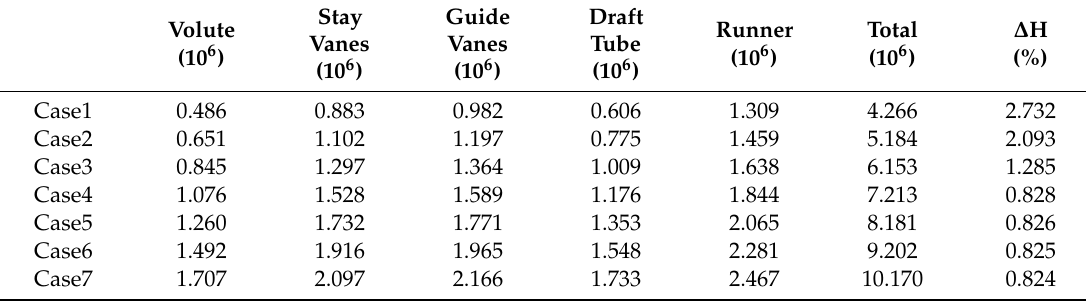
Table 2. Influence of number of grid cells on